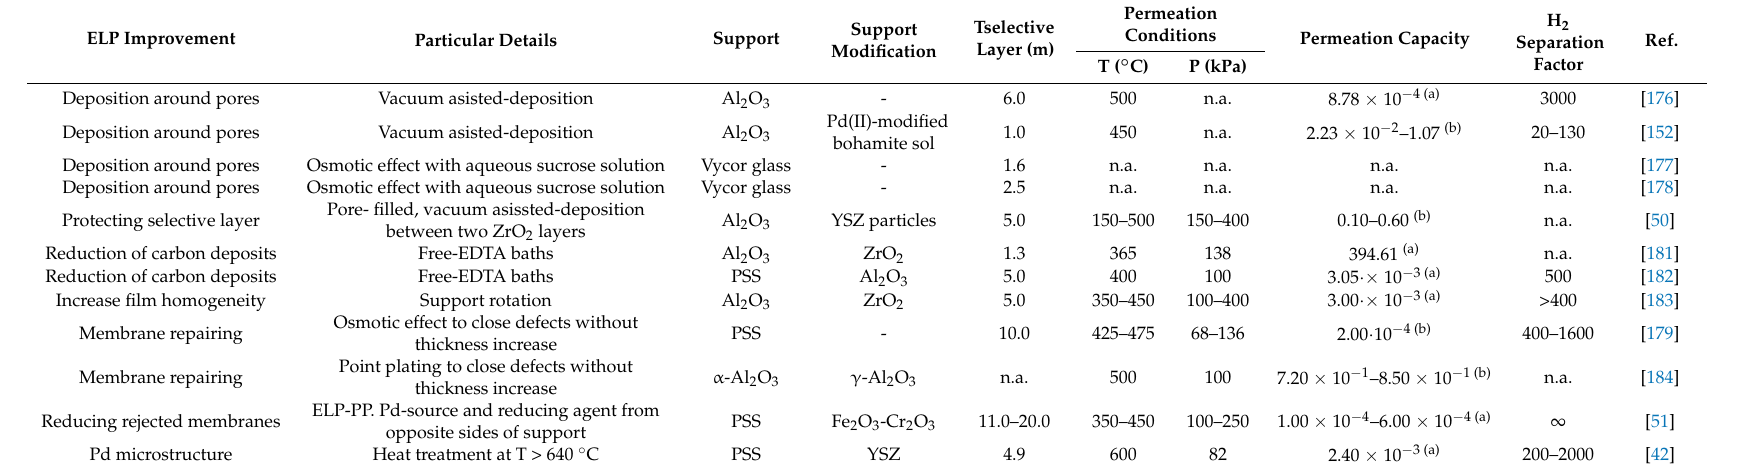
Table 3. Recent improvements on electroless plating to prepare supported Pd-based